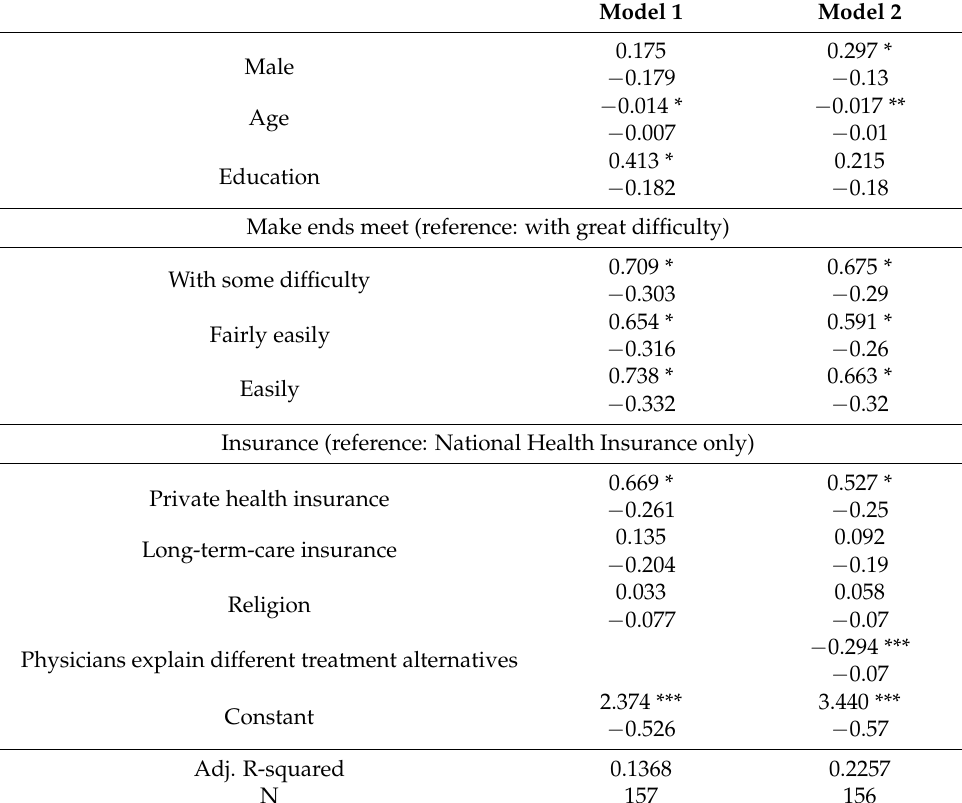
Table 2. Linear regression analysis to explain oncologists’ taking an interest in financial ability to pay for OOP medication and explaining its advantages.